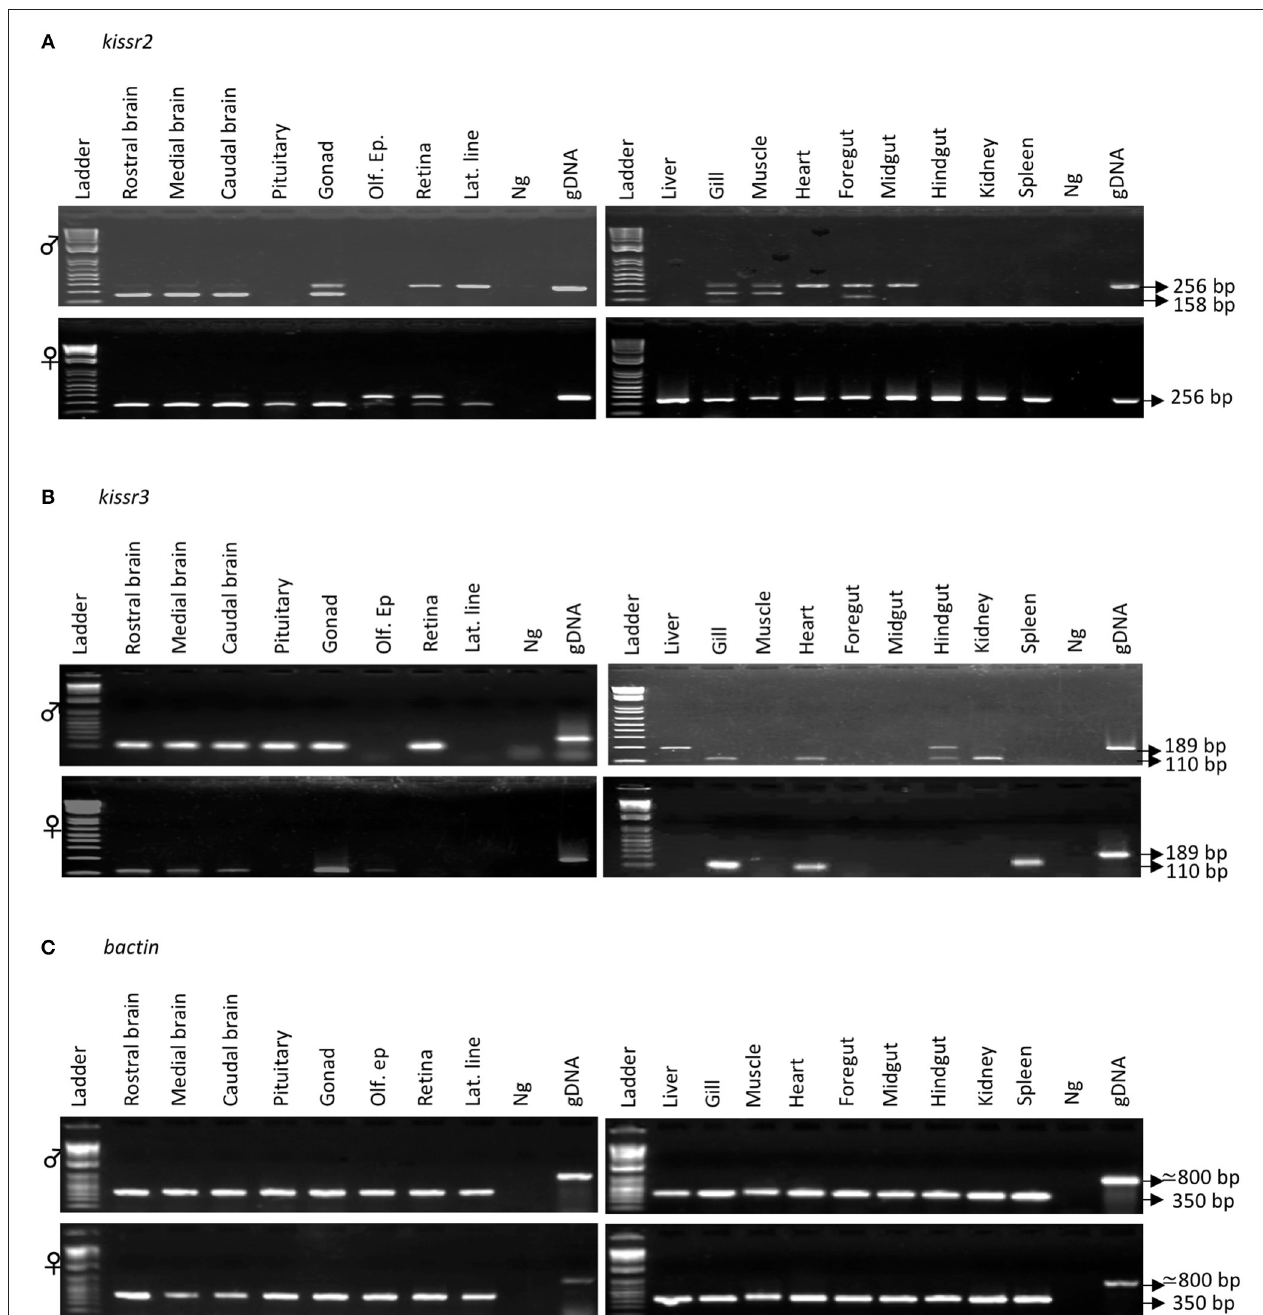
FIGURE 3 | Tissue expression of the kissr2 (A) and kissr3 (B) was analyzed by RT-PCR in mature pejerrey. Total RNA was prepared from rostral brain, medial brain, caudal brain, pituitary, testis (in males), ovary (in females), olfactory epithelium (Olf. Ep), retina, lateral line, liver, gills, muscle, heart, foregut, midgut, hindgut, kidney, and spleen from one male and one female. Messenger RNAs of the two isoforms were detected by RT-PCR (kissr2-Ex3-F/kissr2-Ex4-R and kissr3-Ex4-F/kissr3-Ex5-R primers). Lane 1, 100 bp ladder; Lane 2-8/9, tissues cDNA; Lane 9/10, Negative control (Ng); Lane 10/11, genomic DNA (gDNA). (C) β -actin gene was amplified to check the absence of gDNA and as a control of the cDNA integrity.